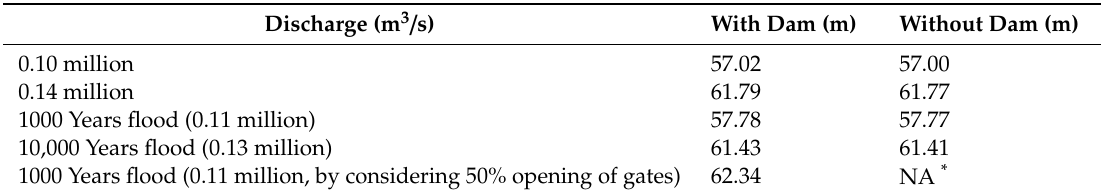
Table 7. Water surface levels at Bhadrachalam with and without dam for di ff erent discharges under 1D steady-state